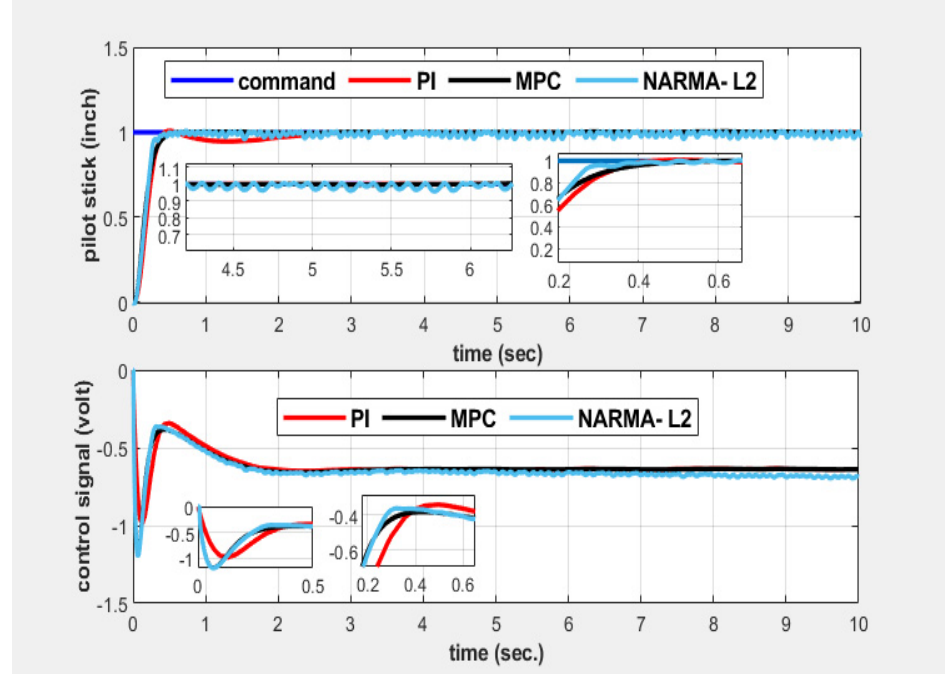
Figure 13. Pilot stick step response.